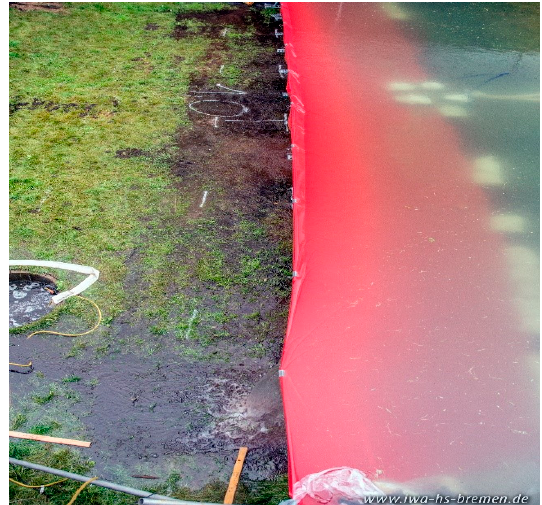
Figure 13. Water overflowing the aqua defence system.